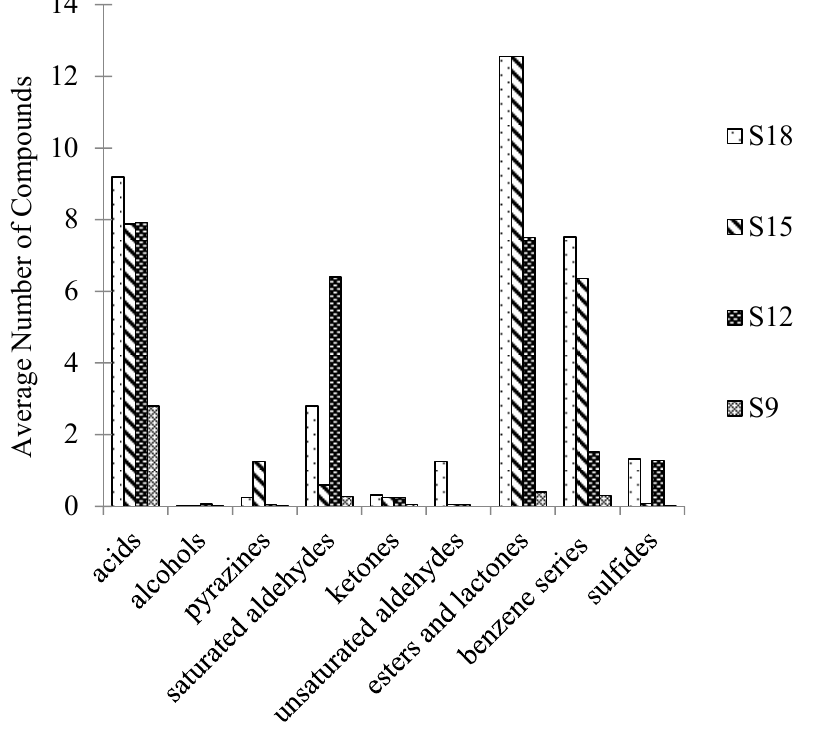
Figure 6. The categories of compounds in Jinhua ham by SAFE. S9, S12, S15 and S18 referred to Jinhua ham processed for 9, 12, 15 and 18 months and application of SAFE was for aroma extraction of samples,